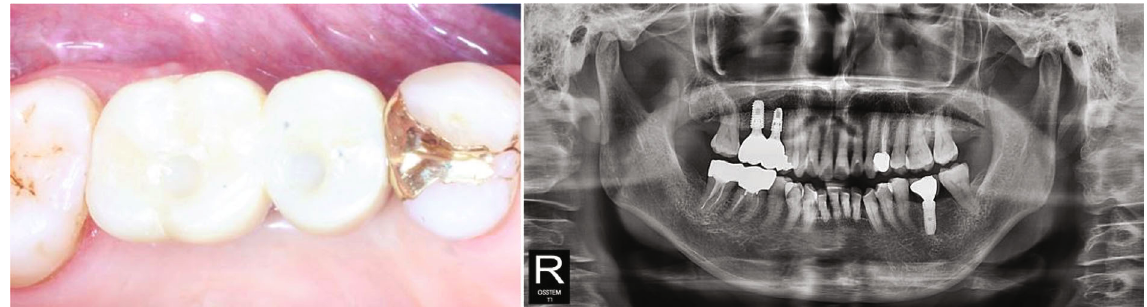
Figure 5: Intraoral and panoramic views after prosthetic rehabilitation (Case 1). The prostheses were maintained well without any speci fi c complications during the follow-up